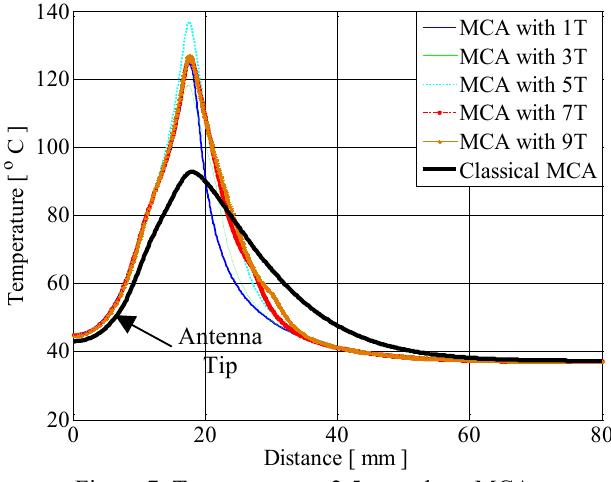
Figure 7: Temperature at 2.5 mm along MCA